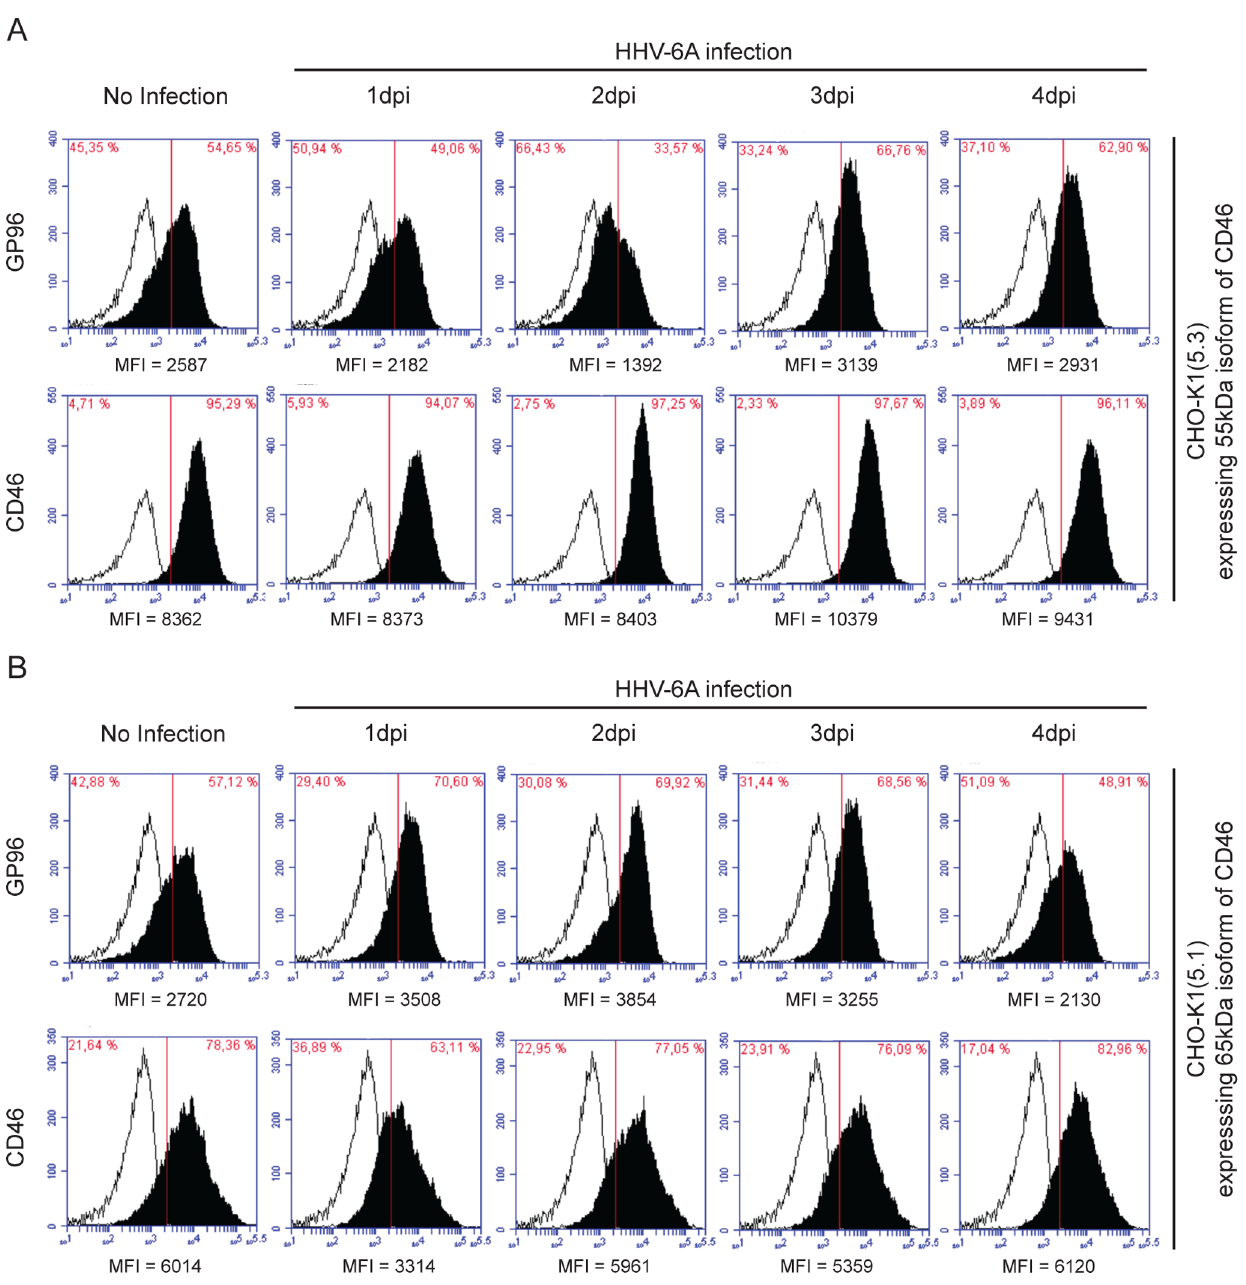
Figure 6. Association of CD46 with GP96 during HHV-6A infection. ( A ) Cell surface expression dynamics of GP96 in CHO-K1 cells stably expressing 55 kDa isoform of CD46. CHO-K1(5.3) cells expressing the 55 kDa isoform of CD46 were infected with HHV-6A for indicated time points. CD46 and GP96 cell surface expression were analyzed by flow cytometry (solid profiles); background fluorescence levels were measured using an isotype specific antibody (empty profiles). ( B ) Cell surface expression dynamics of GP96 in CHO-K1 cells stably expressing 65 kDa isoform of CD46. CHO-K1(5.1) cells expressing the 65 kDa isoform of CD46 were infected with HHV-6A for indicated time points. CD46 and GP96 cell surface expression were analyzed by flow cytometry (solid profiles); background fluorescence levels were measured using an isotype specific antibody (empty profiles). Mean fluorescence intensity (MFI) for each analysis is indicated below the respective